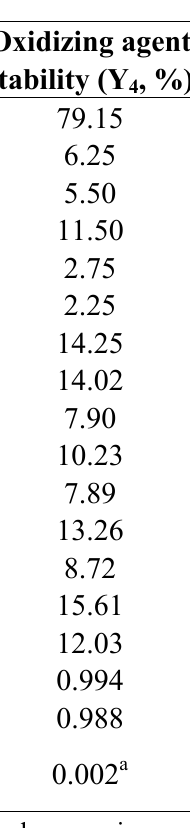
Table 3. Regression coefficients, R 2 , adjusted R 2 probability values of the response surface